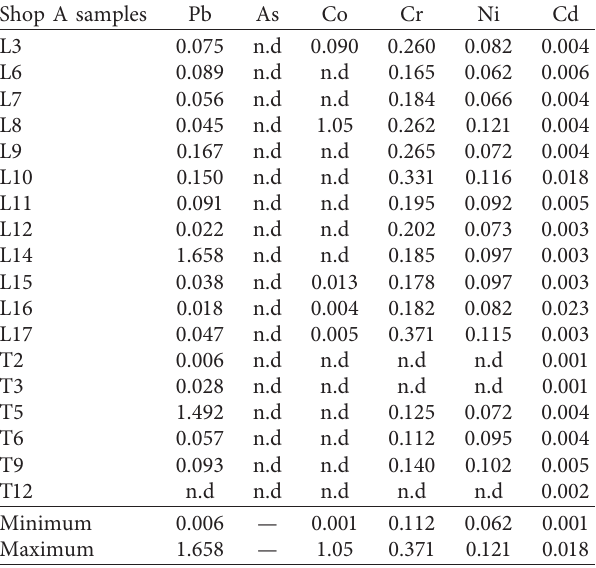
Table 7: Heavy metal concentrations (mg/kg) in various textile apparel after extraction with artificial sweat. Shop A